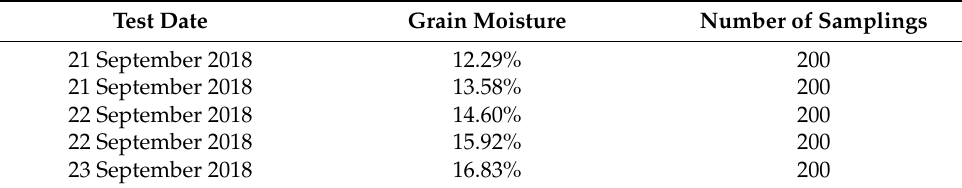
Figure 17. The sensor data acquisition system. Table 3. Test data